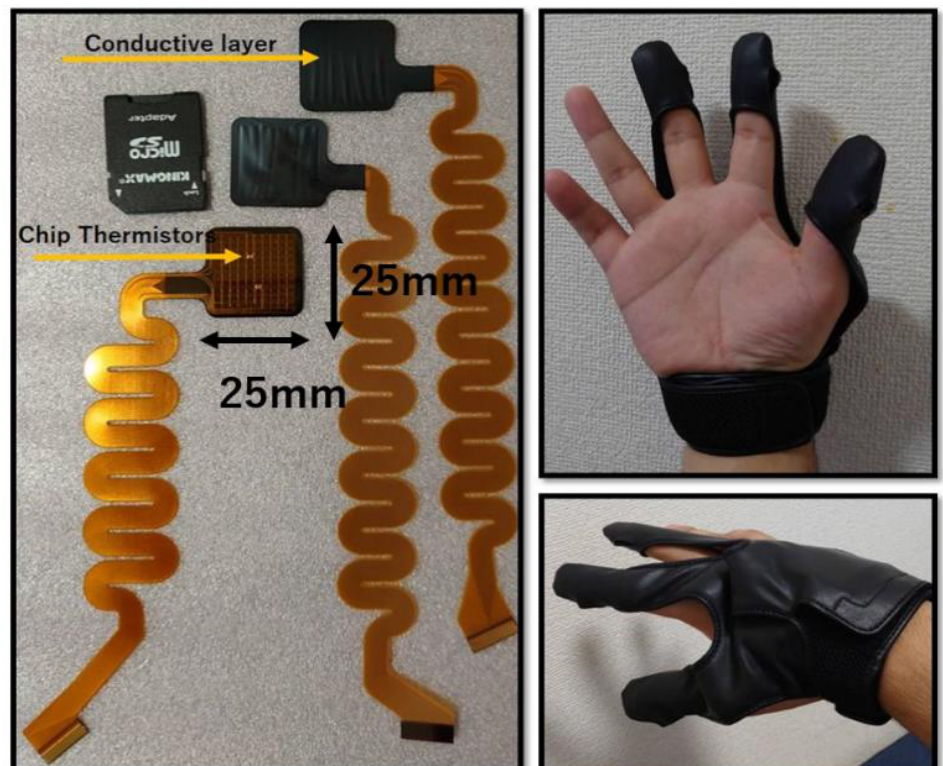
Figure 5. The sensing glove.